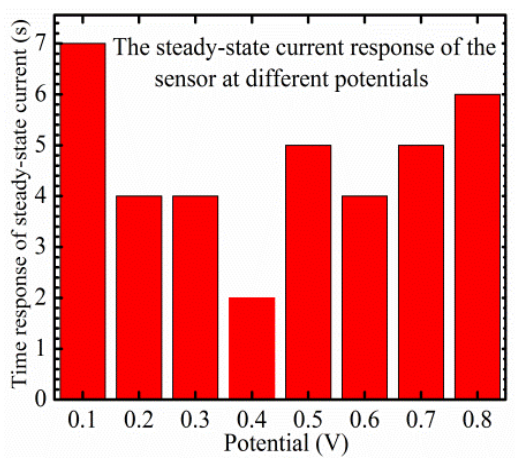
Figure 4. Time response of the steady-state current as a function of different applied potentials as a part of the optimization procedure.